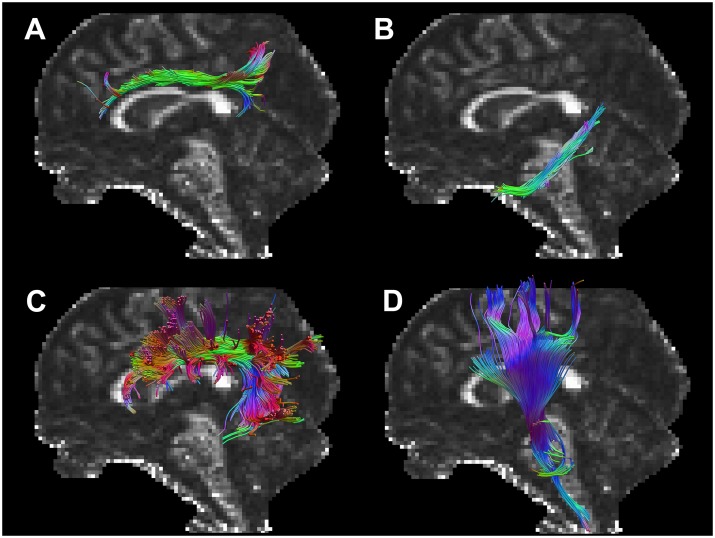
Graphical rendering of tractographies in a representative subject.Tractographies of the left-hand side of the dorsal cingulum (A), the ventral cingulum (B), the superior longitudinal fasciculus (SLF; C), and the corticospinal tract (CST; D) segmented from a whole-brain tractography and superimposed on a mid-sagittal FA map.